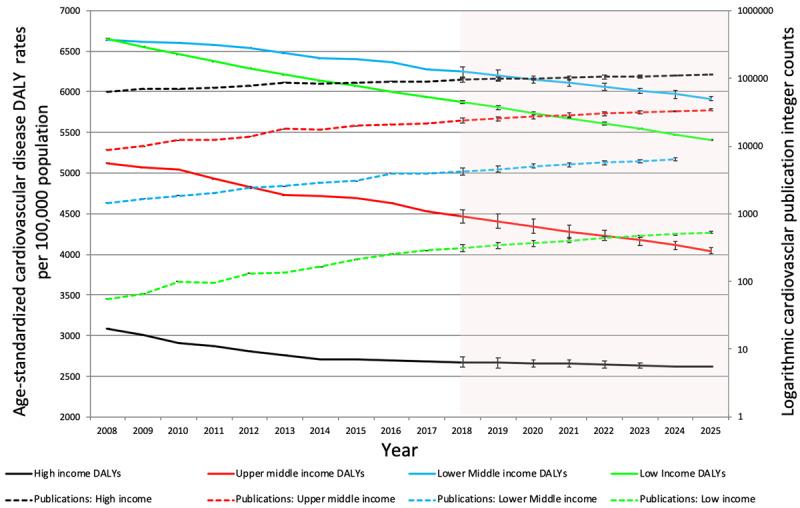
Trends in integer counts of cardiovascular publications and age-standardized DALY rates of cardiovascular disease in World Bank income groups (2008–2017).Shadowed portion represents forecasted values.